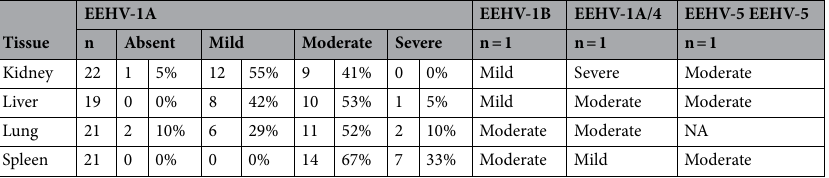
Table 5. Congestion scores in organs from Asian elephant endotheliotropic herpesvirus-haemorrhagic disease fatalities in Europe. NA; tissue not available.